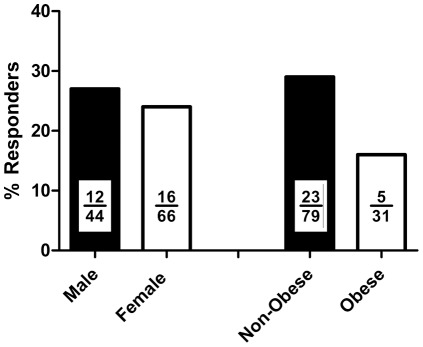
Percentage of subjects responding to DTH induced by candida antigen.Bar insets represent number of positive responders (numerator) over total number of subjects (denominator) in each group.